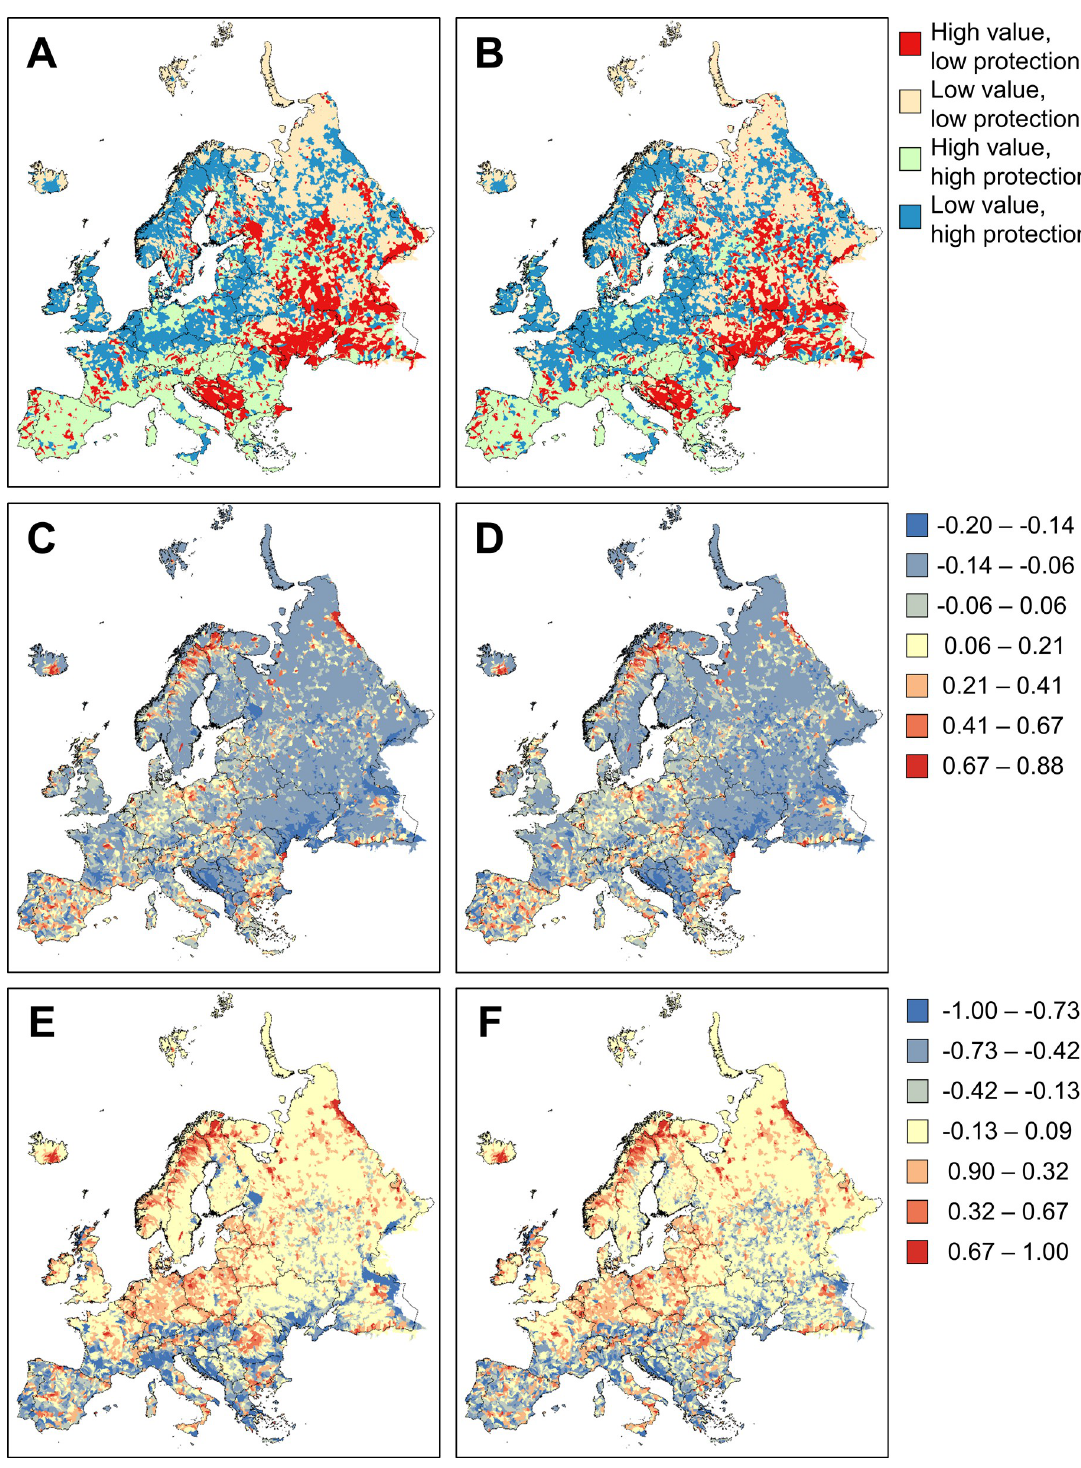
Fig 3. Correspondence between the irreplaceability and the proportion of protected areas per catchment by three methods (rows), each without connectivity (left) or with connectivity (right): distribution of catchments in four combinations of irreplaceability and proportion of protected areas, divided at the medians (A-B); residuals from an ordinary least squares linear regression of irreplaceability over the proportion of protected areas (C-D); and deviations from a hypothetical 1:1000 ideal relationship between proportion of protected areas (range 0 to 1, X axis) and irreplaceability (0 to 1000, Y axis) (E-F). The spatial data for species distributions are deposited